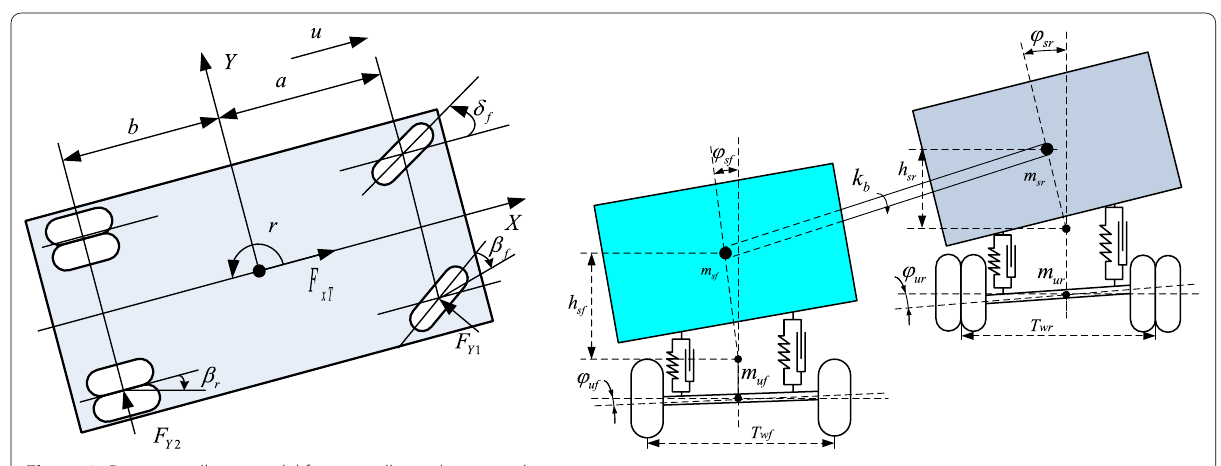
Figure 2 Dynamic rollover model for an intelligent heavy